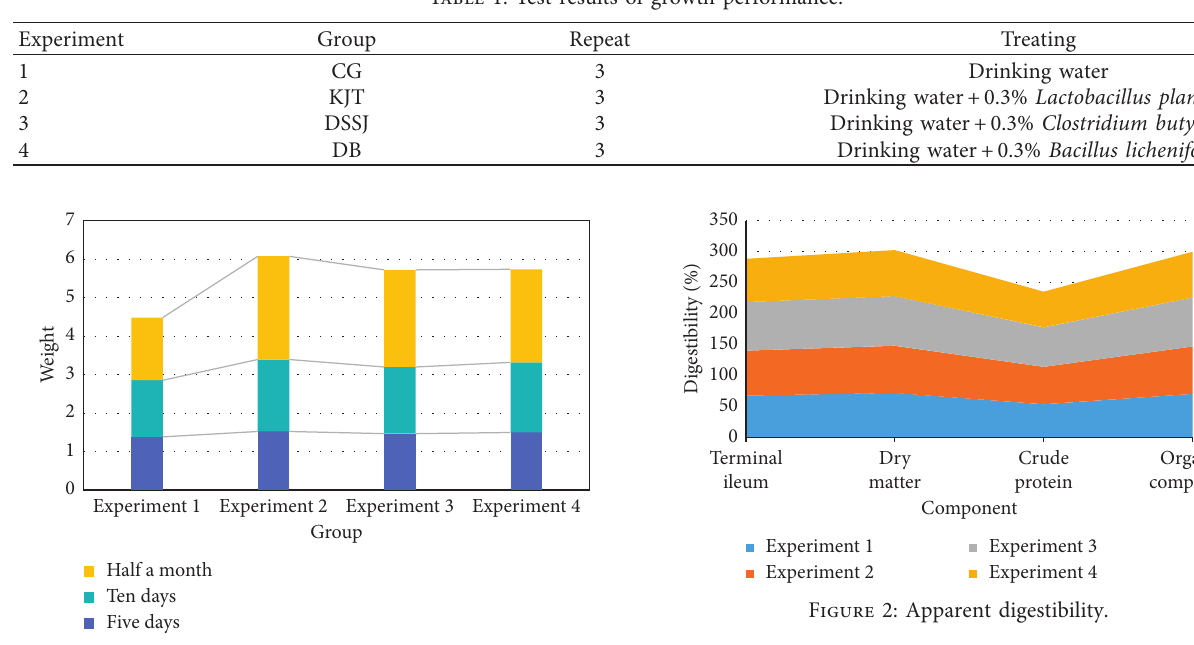
Figure 1: Weight change pattern.